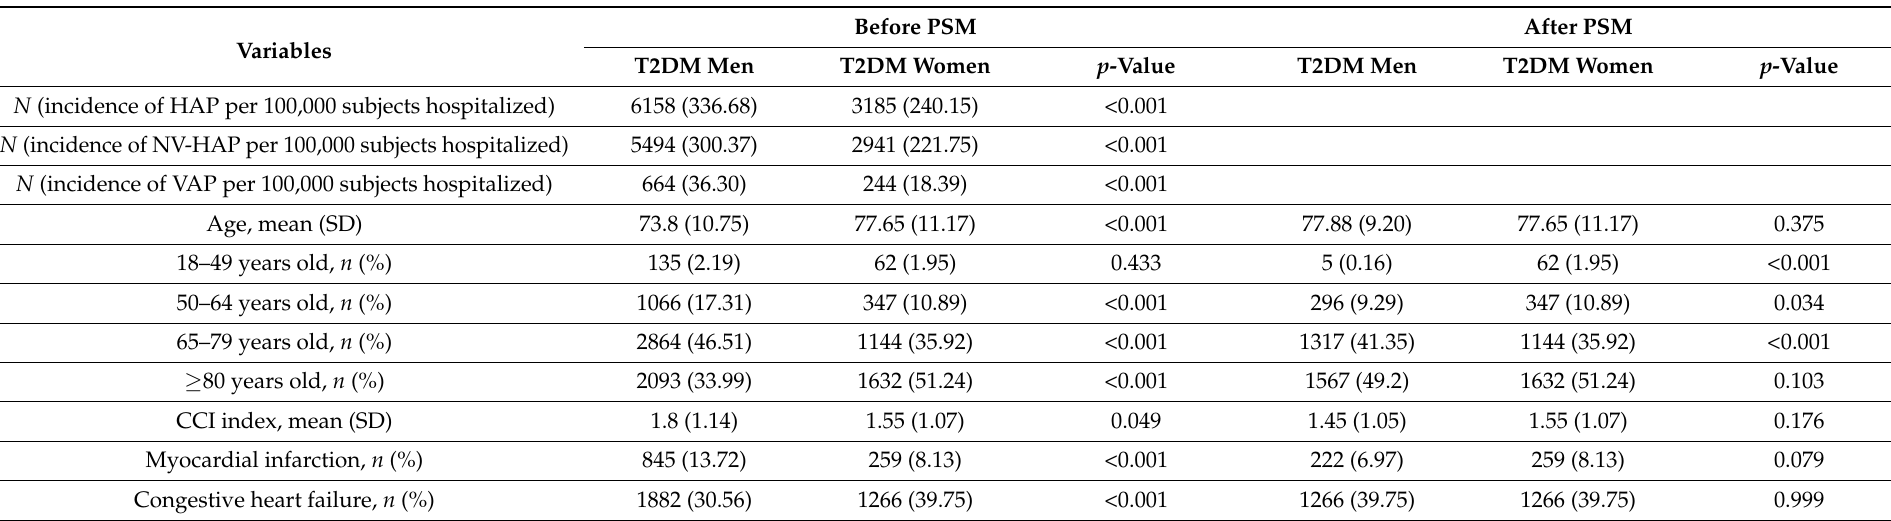
Table 4. Distribution of study covariates and hospital outcomes of men and women with T2DM who developed hospital-acquired pneumonia (HAP) in Spain (2016–2019), before and after propensity score matching